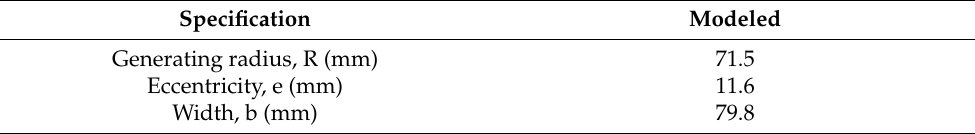
Table 1. Modeled Wankel engine